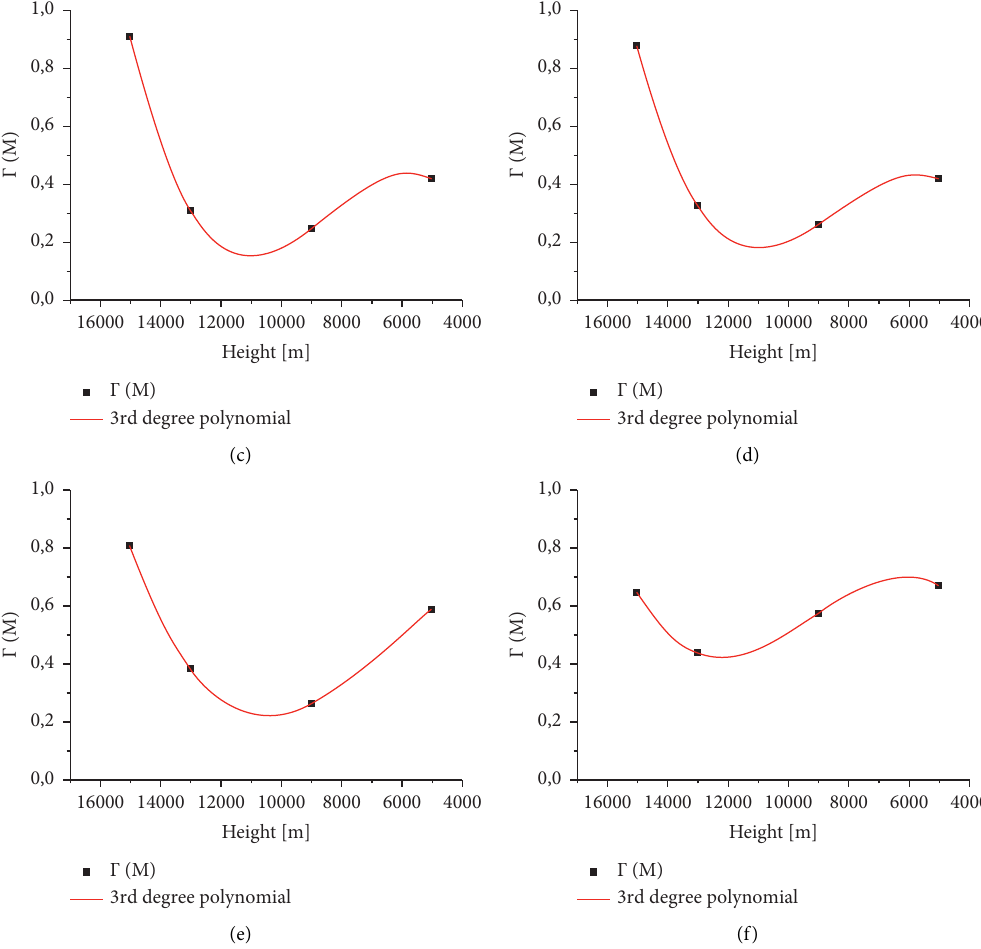
Figure 8: The drag coefficient Γ as function of altitude of the Koˇsice fragment no. 21 (208g) in 6 different orientations. (a) X . (b) IX . (c) Y . (d) IY . (e) Z . (f) IZ .